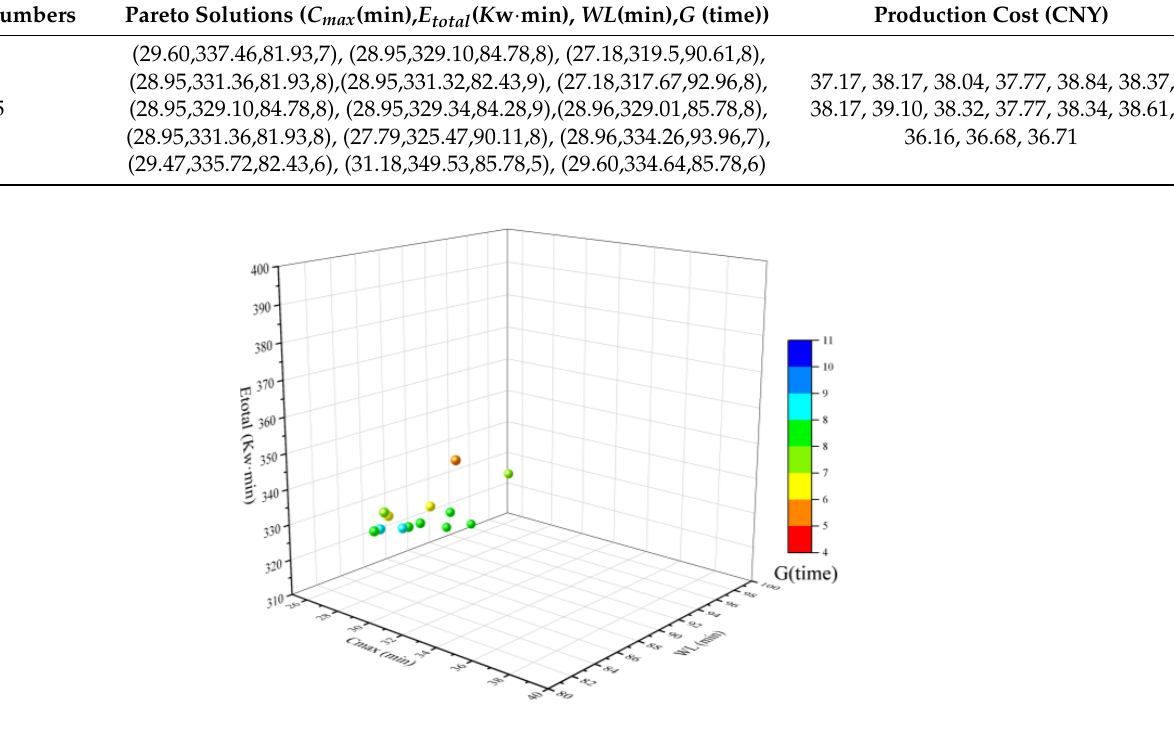
Figure 21. Pareto solutions. Figure 22 is a Gantt chart of Pareto solutions for this example. The X -axis represents the time, the Y -axis represents the machine number, and each block represents an operation. O denotes the machine tool processing operation, e.g., the first block O 5,1 of M 3 indicates that the first process of J 3 was processed on M 3 . CT denotes the cutting-tool change. Idle indicates that the machine tool is not in use, e.g., the gray block on M 6 . On / O f f indicates that the machine tool is turned off, e.g., the green block on M 1 . R _ C _ T indicates that the machine tool is off; however, the cutting tool will be changed at the beginning or end of this period, e.g., the gray-green block on M 2 . S indicates that the machine tool is on standby, e.g., the light blue block on M 5 . The scheduling scheme can provide the appropriate save